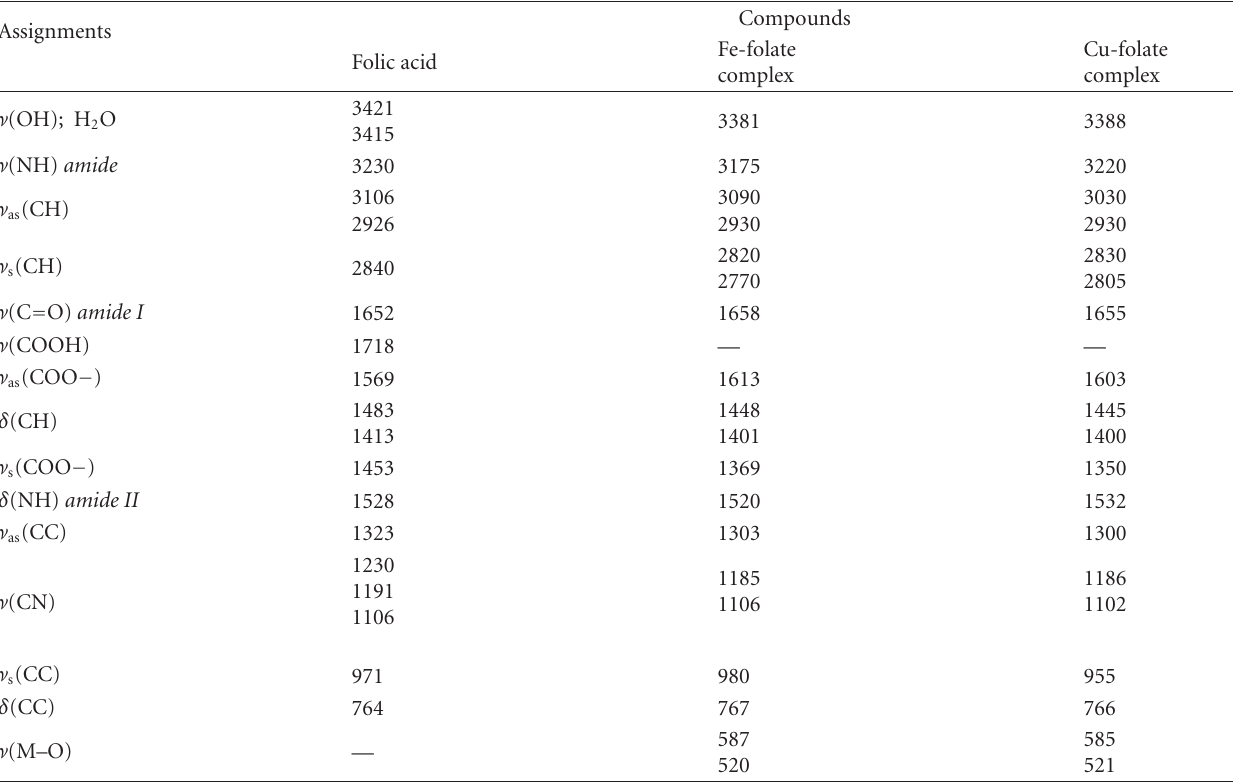
Table 2: IR frequencies (Cm 1 ) of folic acid (FO) and its metal complexes.